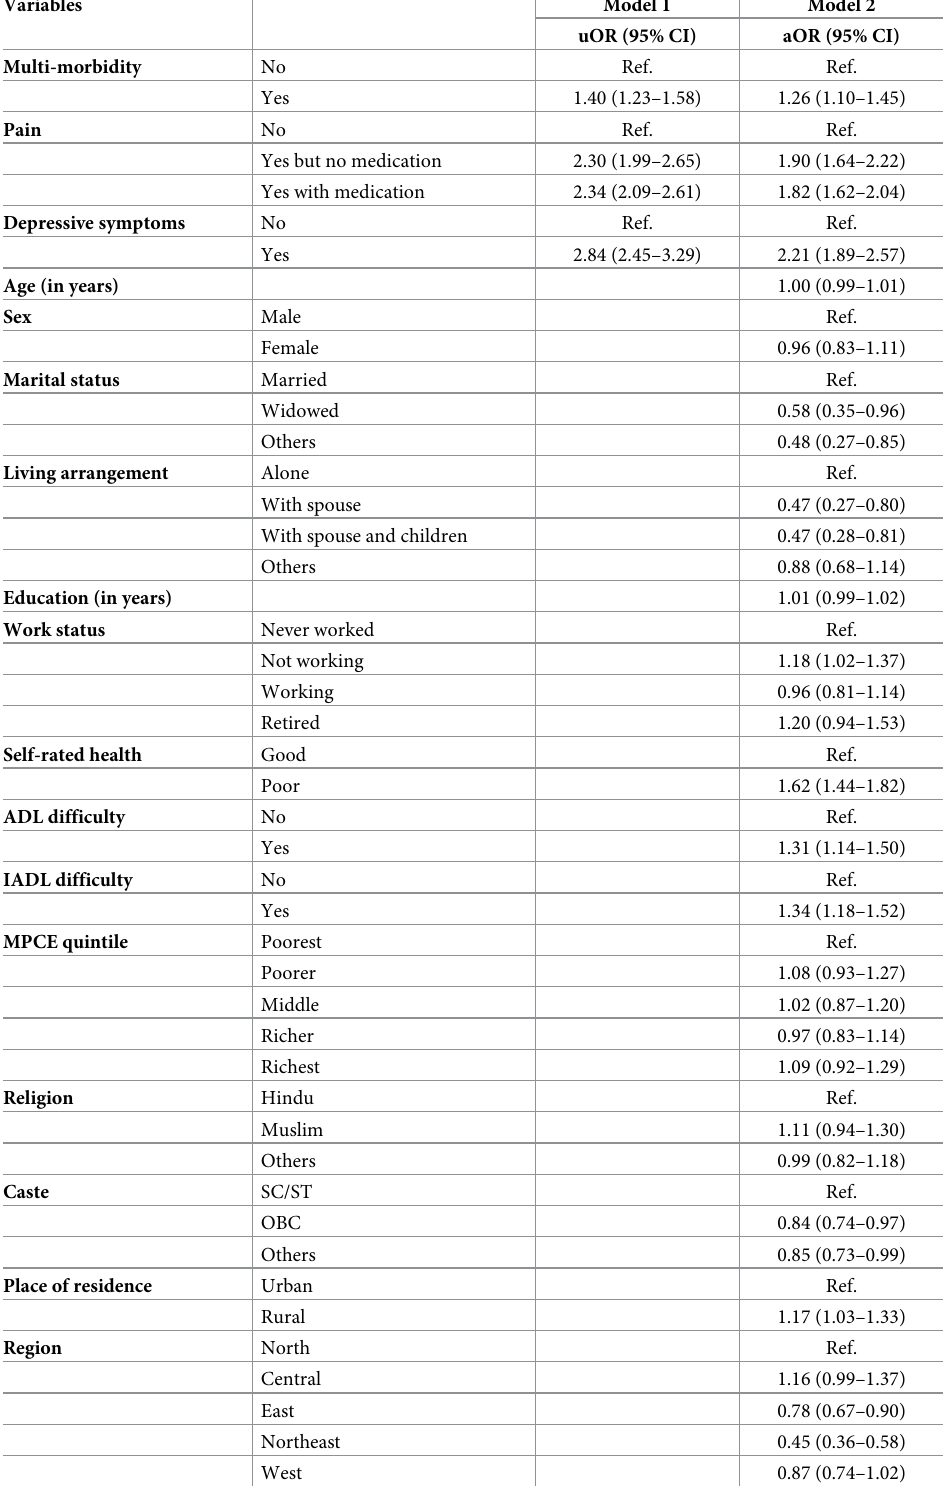
Table 2. Logistic regression estimates of sleep problems by socioeconomic and health characteristics among older adults (n =